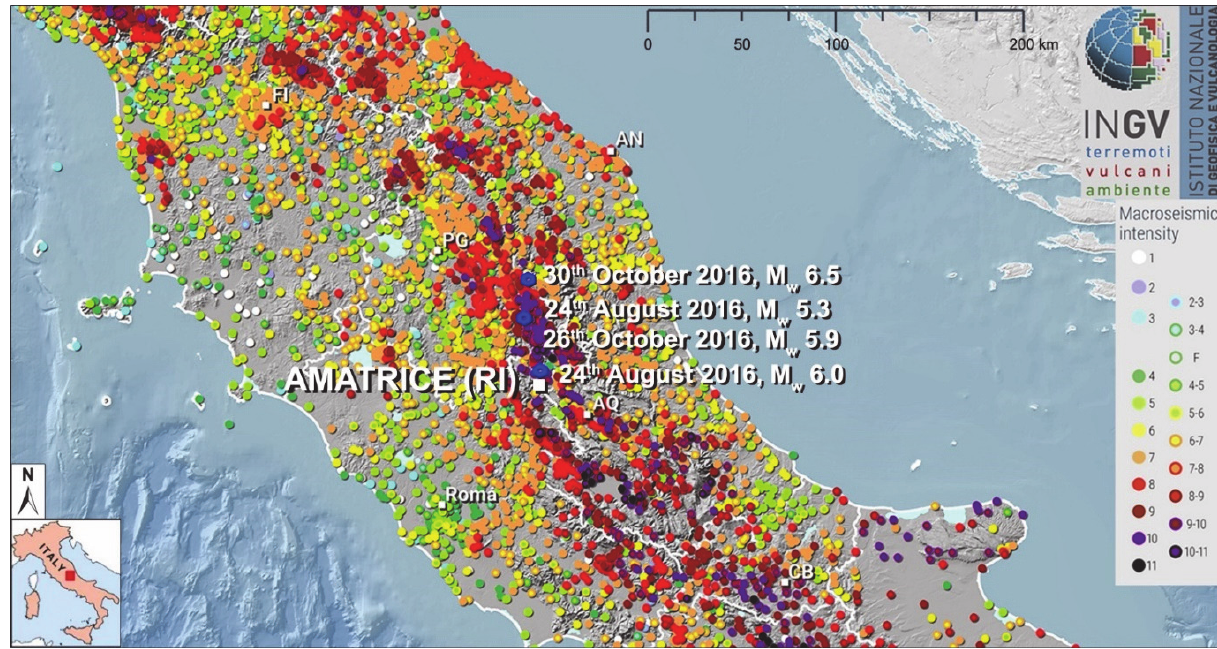
Figure 1: Geographical location of the civic bell tower of Amatrice (Rieti, Italy) and of the epicentres of the four main shocks of the Central Italy seismic sequence of 2016 on the Italian Macro seismic intensity map